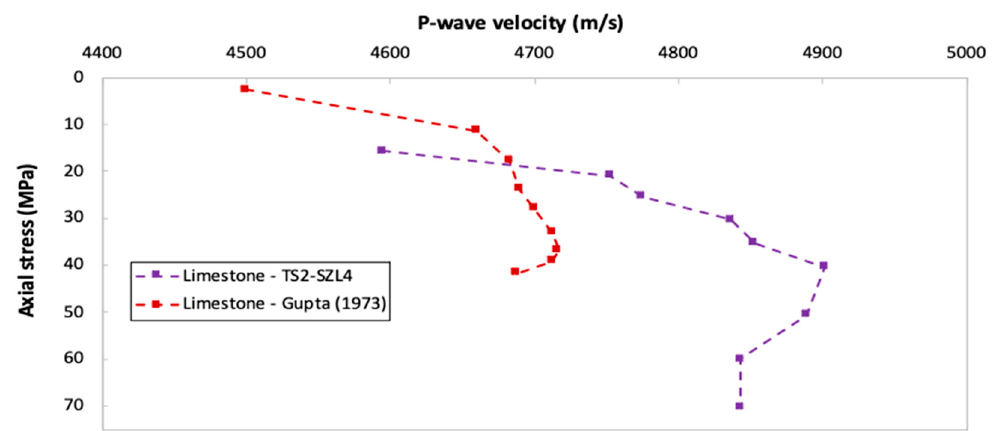
Figure 14. P-wave velocity as a function of axial stress for the limestone sample (TS2-SZL4) used in experimental series A, i.e., the UCS experiments (Figure 5). For comparison purposes, UCS-related acoustic data corresponding to an Indiana limestone sample were taken from [57]. Experimental procedure involves an increasing axial stress until rock failure oc- curred.